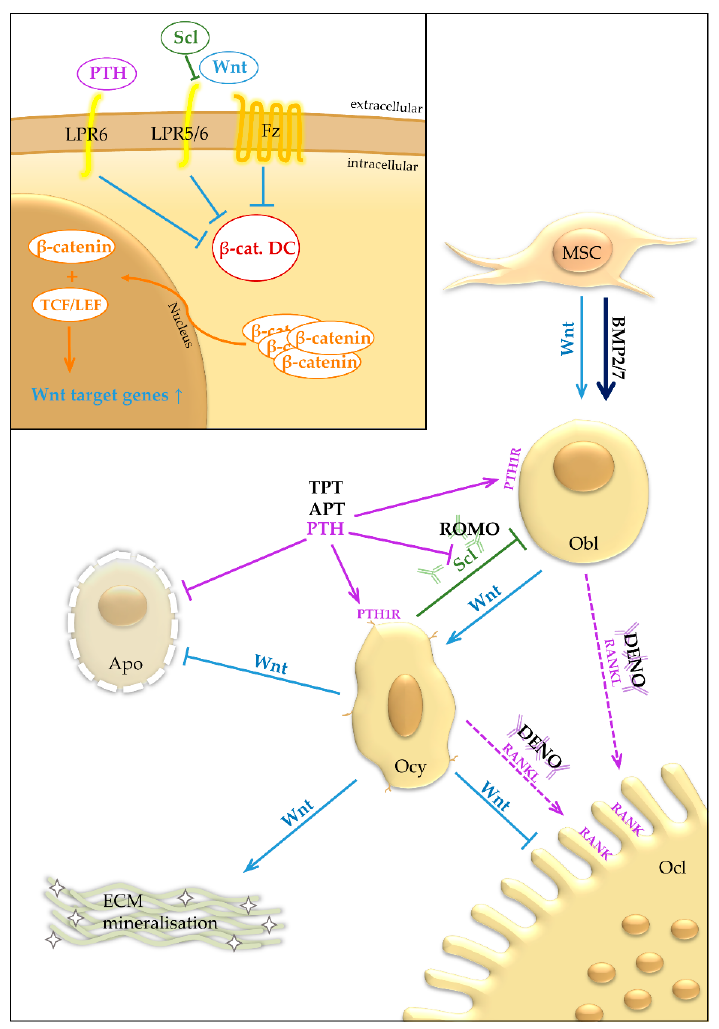
Figure 1. Top left: Wnt binds to the Frizzled receptor (Fz) and the LRP5/6 co-receptor. LRP5/6 and Fz deactivate the β -catenin destruction complex, which leads to accumulation of β -catenin. β -catenin translocates into the nucleus, where it regulates transcription of Wnt target genes with TCF/LEF. Sclerostin inhibits binding of Wnt to LRP5/6. PTH binds to LRP6 and causes an Wnt-independent deactivation of the β -catenin destruction complex. bottom: Wnt promotes the osteoblastic lineage and inhibits osteoclastogenesis and apoptosis. BMP is a strong promoter of osteoblastic differentiation. PTH acts through the PTH1R receptor in the osteoblastic lineage and has an inhibiting effect on sclerostin expression. APT and TPT work through selective activation of PTH1R activation. ROMO binds sclerostin. DENO binds RANKL and prevents RANK activation. Apo, Apoptosis; APT, Abaloparatide, parathyroid hormone-related protein analogue; β -cat. DC, β -catenin destruction complex, targets β -catenin for ubiquitination and subsequent degradation in the proteasome; BMP2/7, Bone morphogenetic protein 2 and 7; DENO, Denosumab, monoclonal antibody against RANKL; ECM, Extracellular matrix; Fz, Frizzled receptor, G-protein coupled receptor, target for Wnt; LRP5/6, Low-density lipoprotein receptor-related protein 5 or 6; LRP6, Low-density lipoprotein receptor-related protein 6; MSC, Mesenchymal stem cell; Obl, Osteoblast; Ocl, Osteoclast; Ocy, Osteocyte; PTH, Parathyroid hormone; TPT, Teriparatide, peptide Fragment of PTH; PTH1R, parathyroid hormone 1 receptor; RANK, Receptor Activator of NF- κ B; RANKL, Receptor Activator of NF- κ B Ligand; ROMO, Romosozumab, monoclonal antibody against sclerostin; Scl, Sclerostin; TCF/LEF, T cell factor/lymphoid enhancer factor; Wnt, Wingless-related integration site/Wnt signalling pathway.